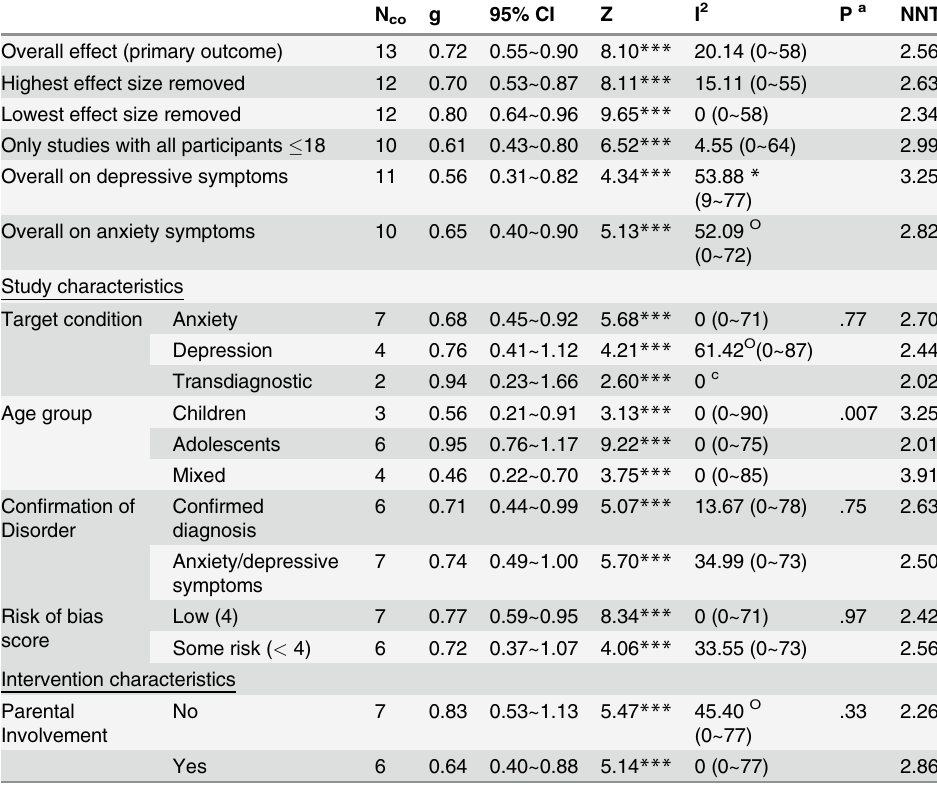
Table 2. Effects of computer and internet-based CBT for anxiety and depression in youth when compared with control groups at post-test: Hedges ’ g. N co